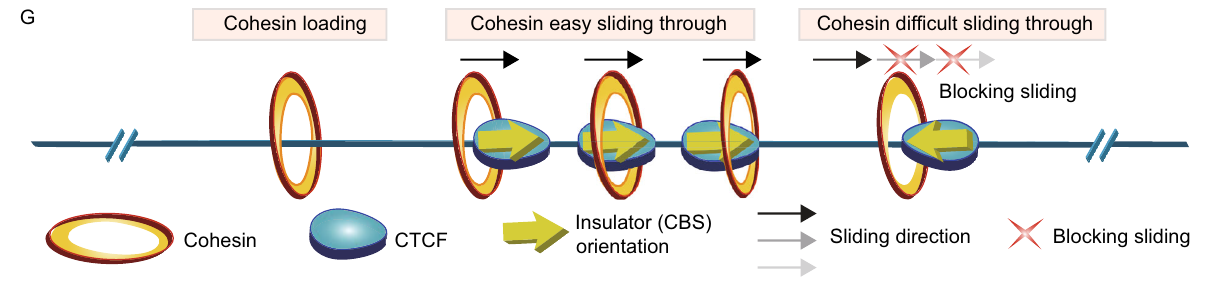
b Figure 2. Genetic dissection of the super-enhancer of the Pcdh βγ clusters by CRISPR DNA-fragment editing . (A) RNA-seq results of the expression of distinct isoforms of the Pcdh βγ clusters in mouse Neuro2A cells. (B) The 4C interaction pro fi les of distinct isoforms of the Pcdh βγ clusters with the HS7L , HS5-1bL , or HS18-20 as a viewpoint. (C) Schematic showing the dual-sgRNAs-mediated DNA-frag- ment inversion of the super-enhancer CBSs b-e in mice in vivo . Note the upstream staggered cleavage at − 4 positon on the noncomplementary strand by Cas9. (D) Con fi rmation of upstream and downstream junctions of the CBSs b-e inversion mice by Sanger sequencing. (E) 5C heatmap of the entire Pcdh locus in P0 mouse brain tissues. (F) RNA-seq showing a signi fi cant decrease of expression levels of members of the Pcdh β cluster. Data are means ± SEM ( n = 2). * P < 0.05, ** P < 0.01, *** P < 0.001. (G) An asymmetric blocking model of cohesin sliding by directional CTCF binding to oriented insula- tors as suggested by genetics data. e